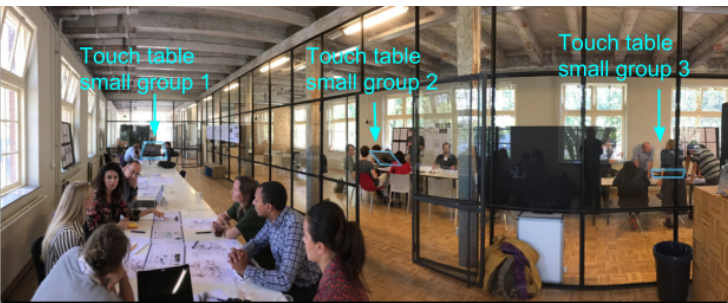
Figure 10. The GDSE runs on three touch tables (outlines are highlighted in light blue), with each one supporting the work of one of the three small groups of participants. Photo: author Marcin Dąbrowski.